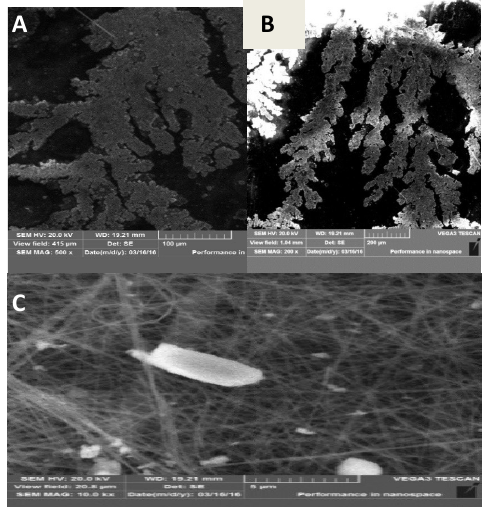
Fig. 13. SEM of membrane after exposing to bacteria where the bacteria cluster (a) on the membrane surface as a dendritic shape colony (b) and (c) shows how fiber captures the bacteria.